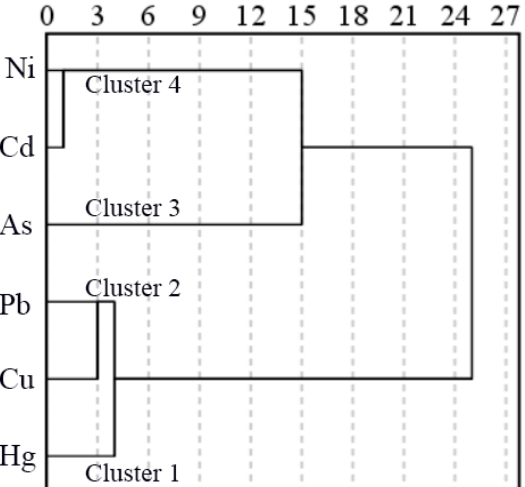
Figure 7. Hierarchical dendrogram of heavy metals was obtained using Ward’s clustering.